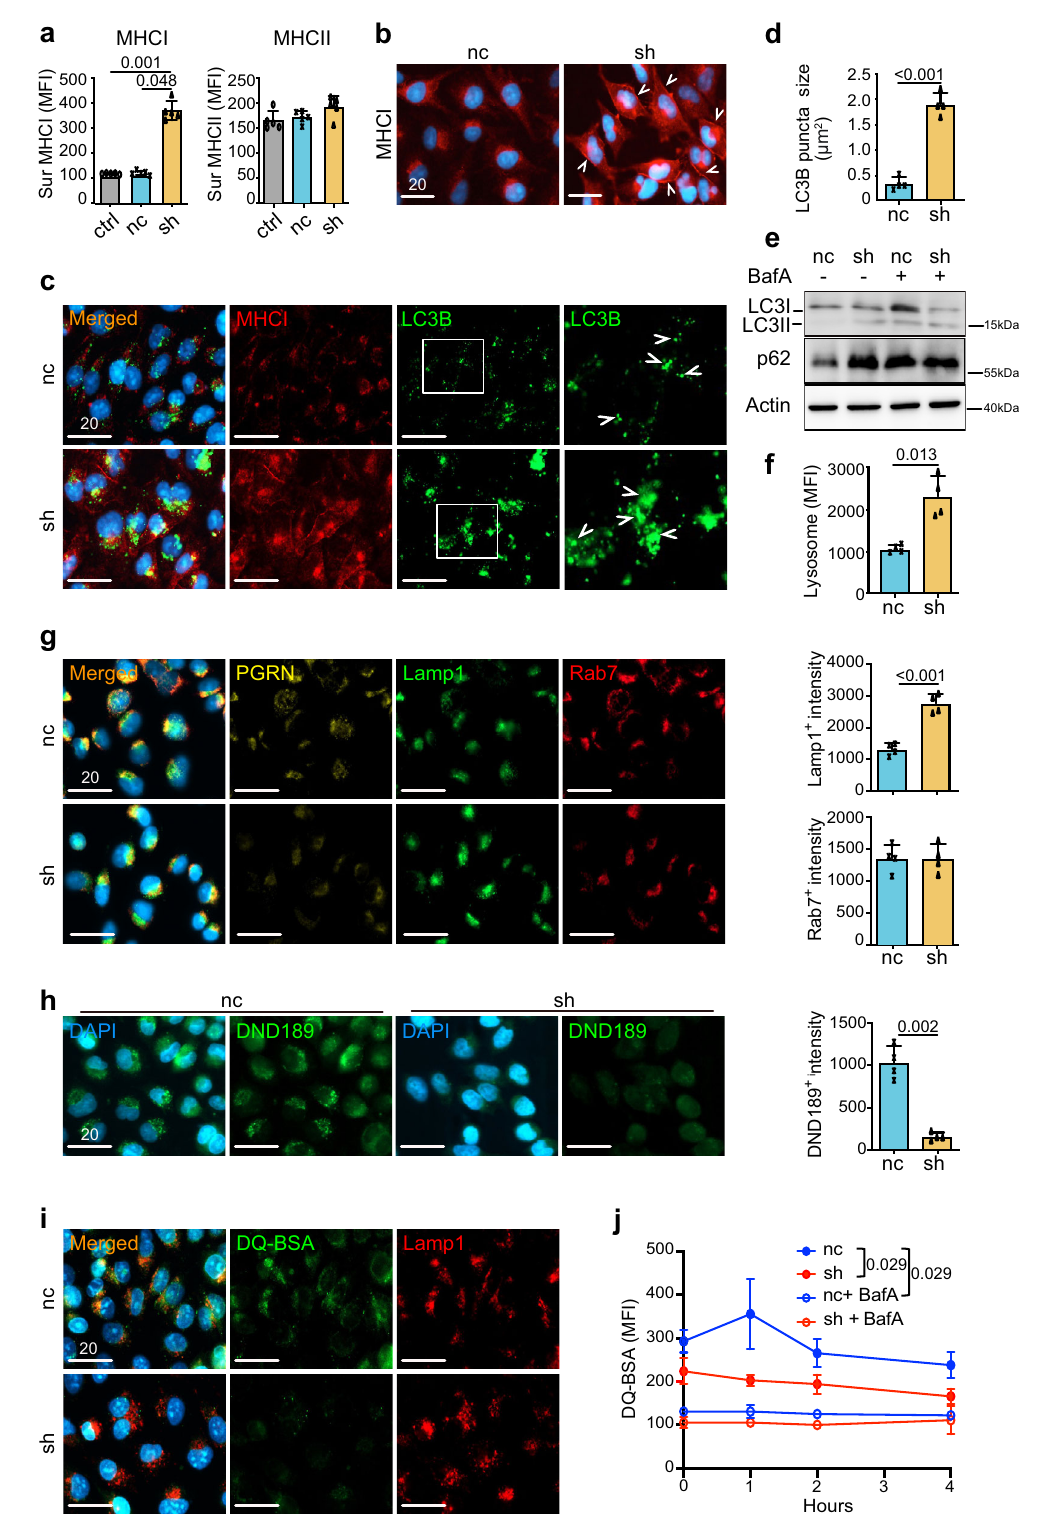
PaTu8988T cells with anti-PGRN Ab in vitro, and both cellular and secretory PGRN levels were signi fi cantly reduced upon Ab treatment (Supplementary Fig. 5a, b), supporting subsequent targeting of cellular and circulating PGRN in